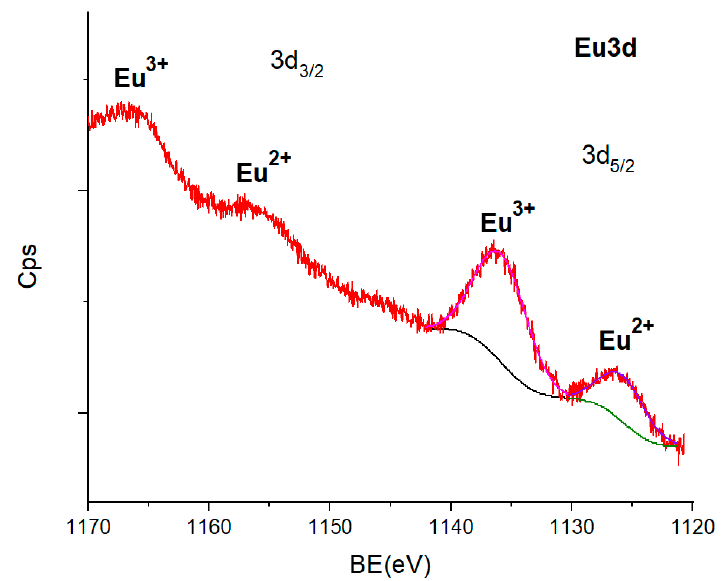
Figure 7. The XPS spectrum of the Eu 2+ -doped SiO 2 -CaF 2 glass-ceramic annealed in a reducing atmosphere is shown in the Eu3d spectral line region and its deconvolution in the Eu 3d 5/2 line region